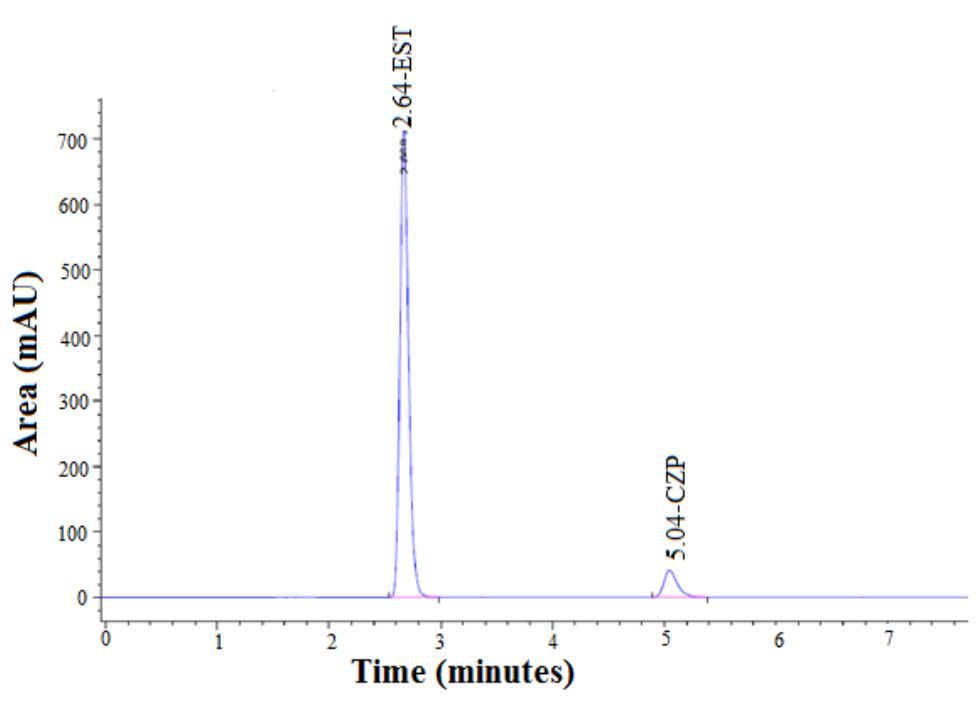
Figure 10. Representative calibration curve of ( A ) EST and ( B ) CZP.